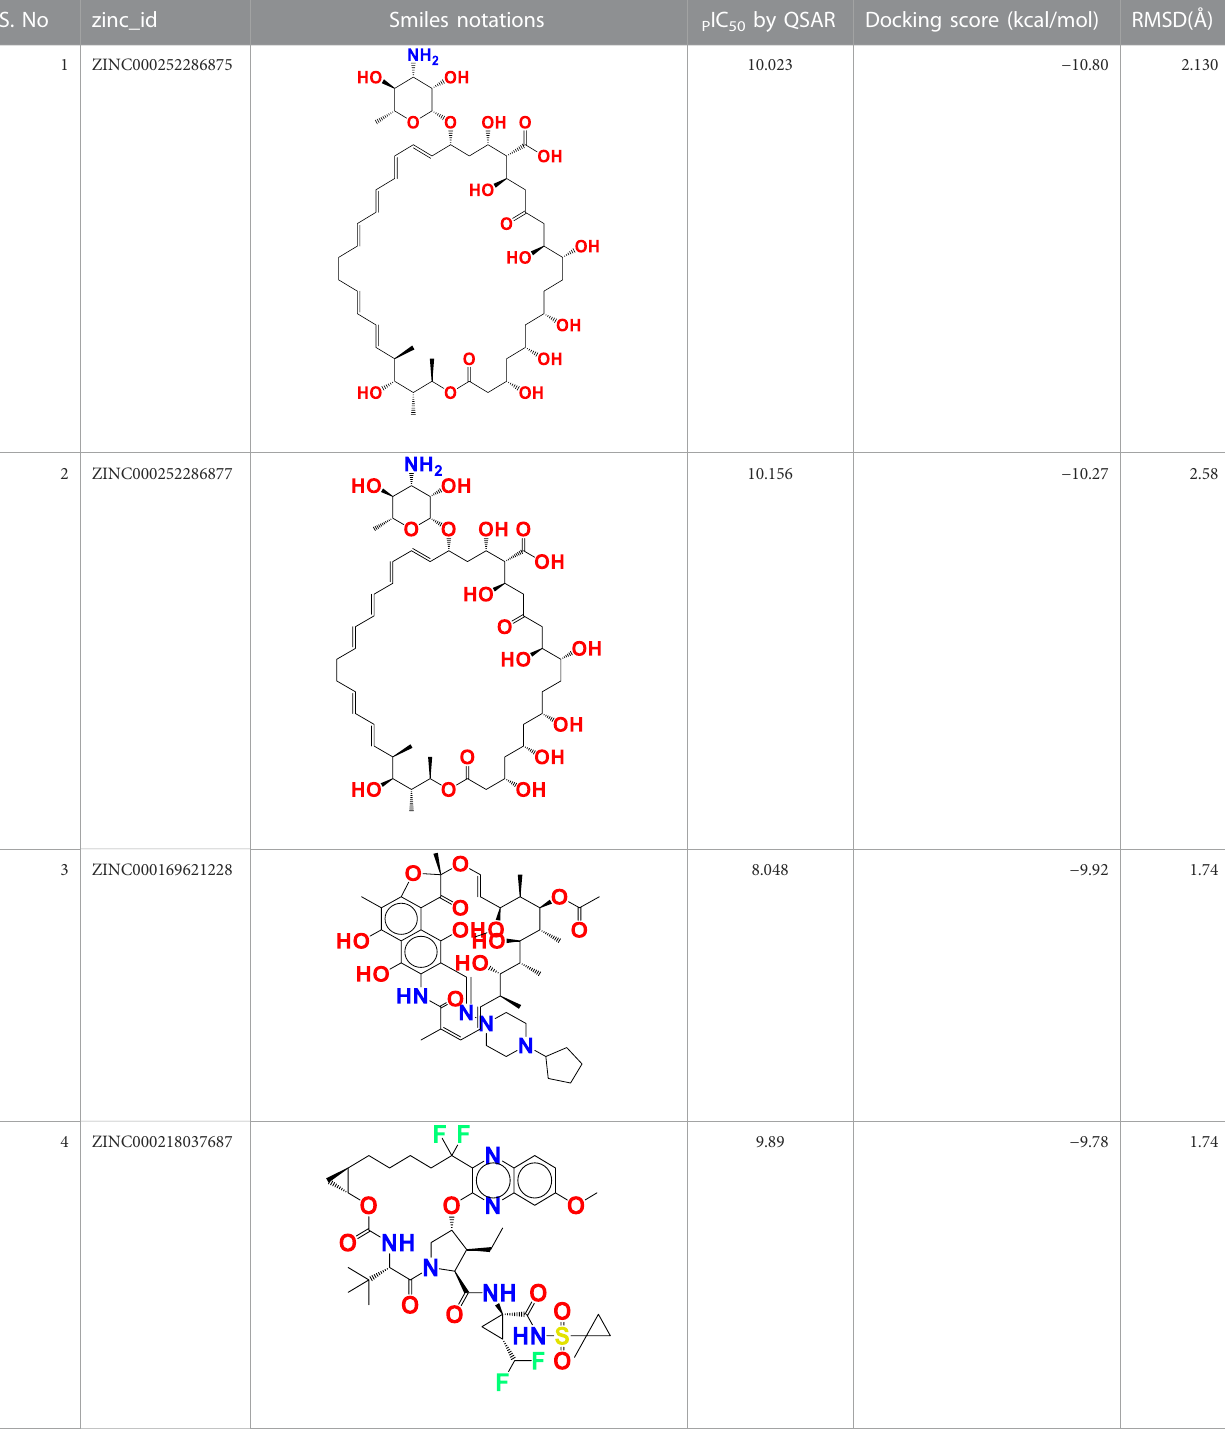
TABLE 3 Presentation of zinc id, structures, P IC 50 Predicted by QSAR vs, Docking Score (Kcal/mol), and RMSD(Å) for top 10 FDA molecules. S.